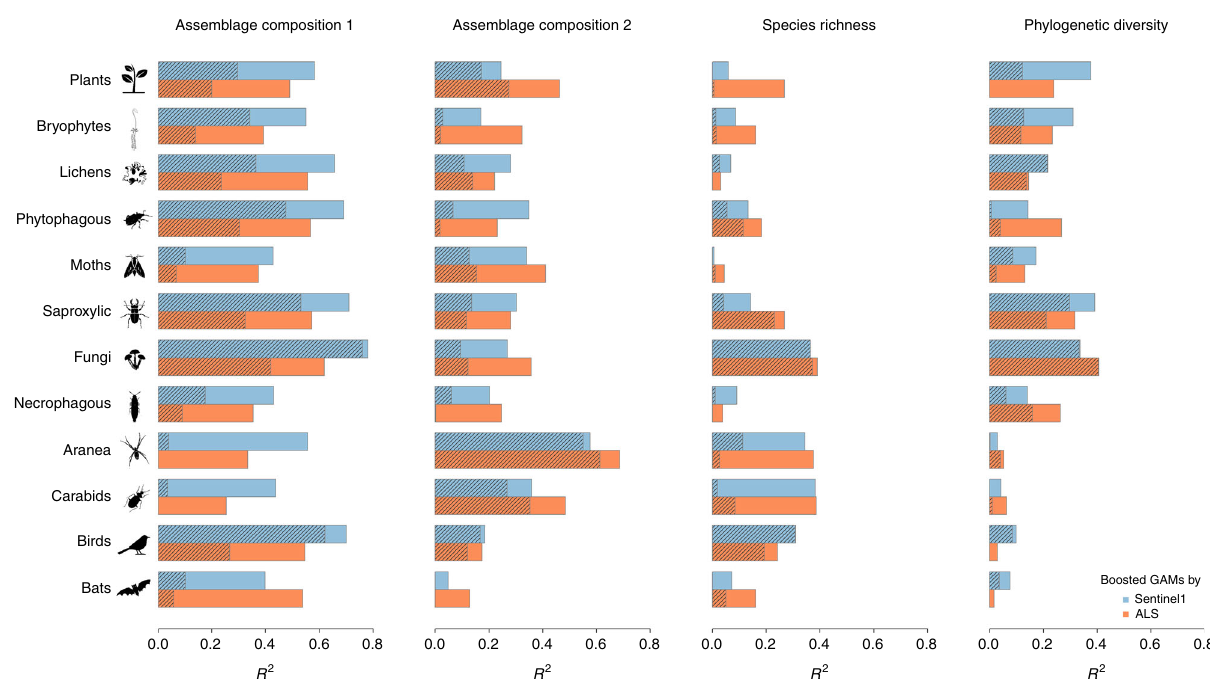
Fig. 3 Predictive power of radar and ALS in modelling different aspects of biodiversity. Cross-validated performance ( R ², coef fi cient of determination) of assemblage habitat models (boosted generalised additive models), i.e. fi xed effects models, using the ALS (orange bars) and radar (blue bars) data sets. The shaded bars represent R 2 derived from the mixed effects models. For mixed effects models, R ² was calculated using only the fi xed factors to predict the response variables, in order to exclude the variance explained by